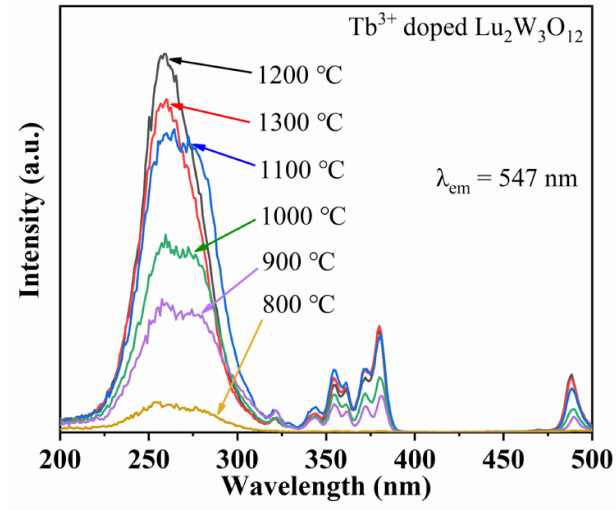
Figure 6. Preparation of temperature-dependent PL excitation spectra of Tb 3+ -doped Lu 2 W 3 O 12 phosphors.